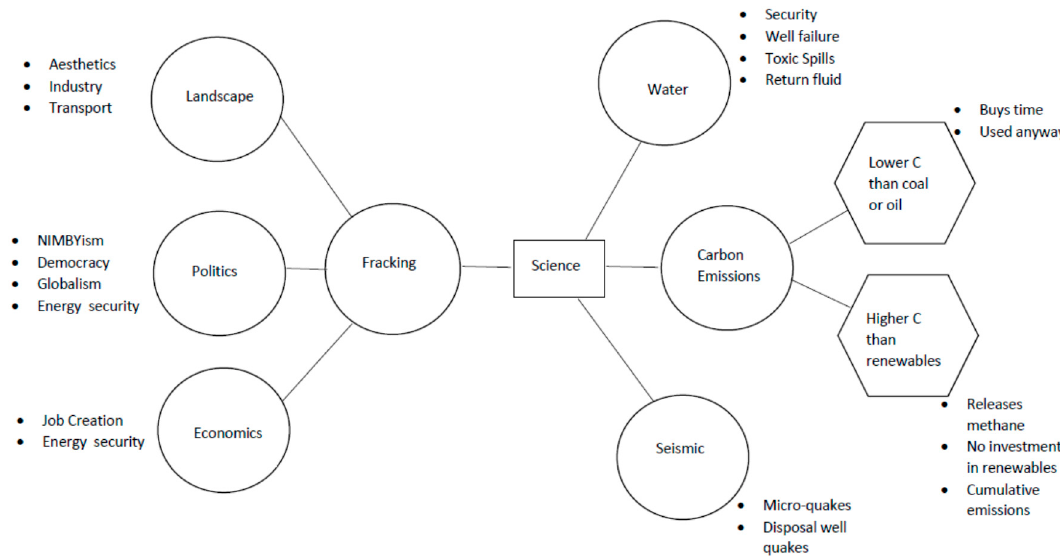
Figure 1. Mind map of potential advantages and disadvantages of fracking as drawn from the literature.